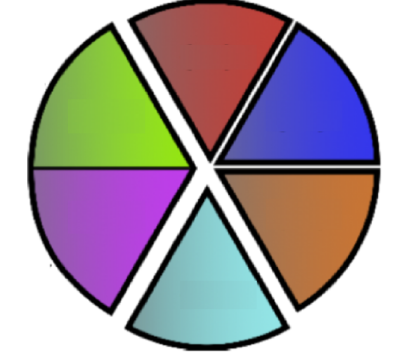
Figure 3 . “Hodge Duality” dissection of BC 4